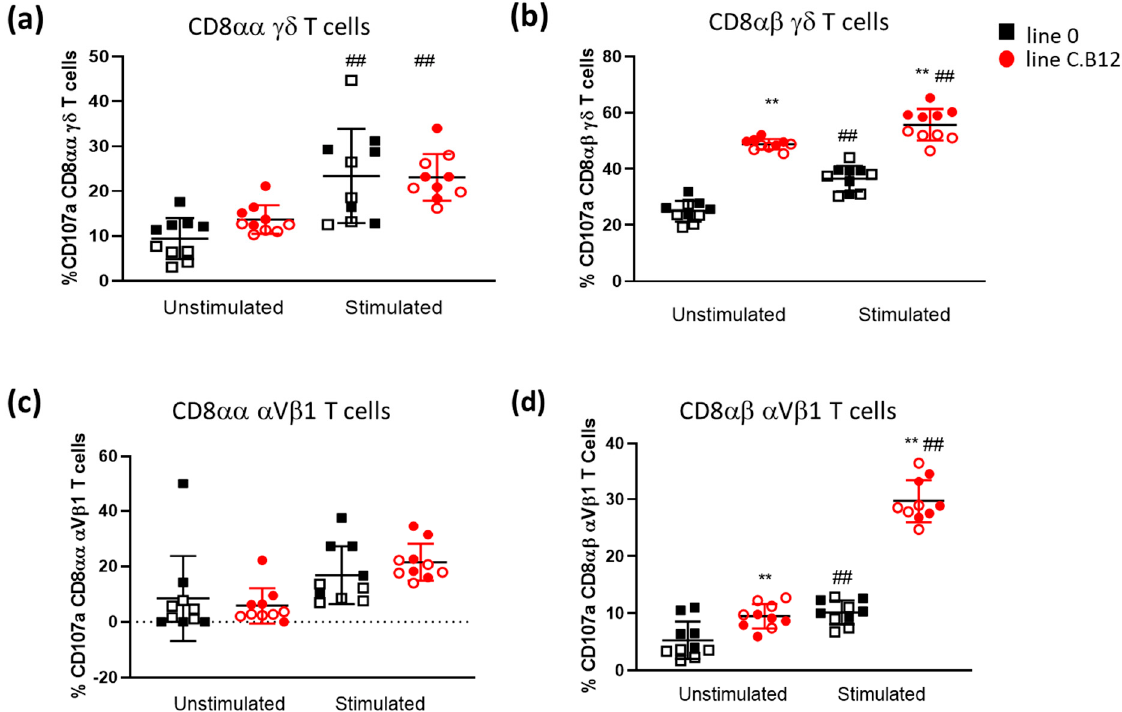
Figure 3. CD107a degranulation assay of γδ T and α V β 1 + T cell subsets in the spleen of line 0 and line C.B12 birds. Flow cytometric analysis of surface CD107a on naïve and stimulated γδ T cells ( a , b ) and α V β 1 + T cells ( c , d ) isolated from the spleens of 4-week-old line 0 (black) and line C.B12 (red) birds. CD8 αα + populations ( a , c ) and CD8 αβ + populations ( b , d ). ** p < 0.01 between lines, ## p < 0.01 within lines. Filled symbols represent experiment 1 and open symbols represent experiment 2; n = 10 birds per line. Black bar represents the mean. Error bars represent the standard deviation .